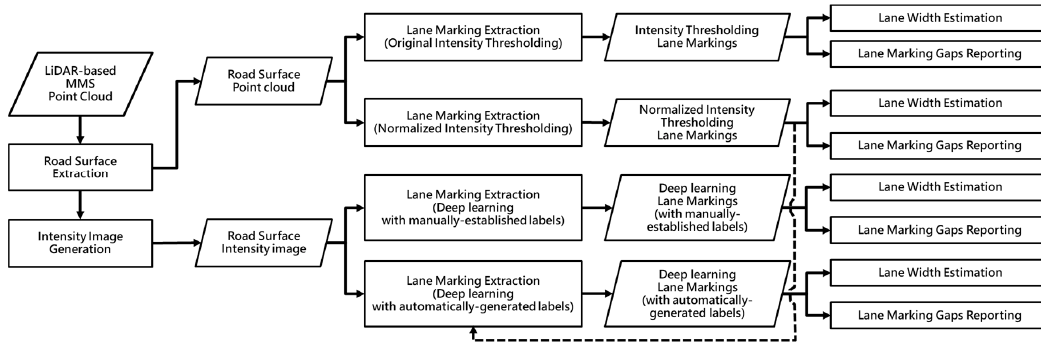
Figure 4. Flowchart of the proposed framework for lane marking extraction and lane width estimation.